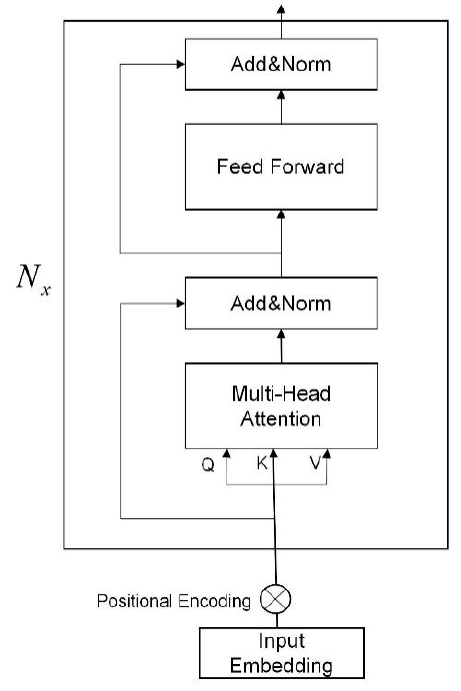
Figure 2. Structure of the transformer encoder.